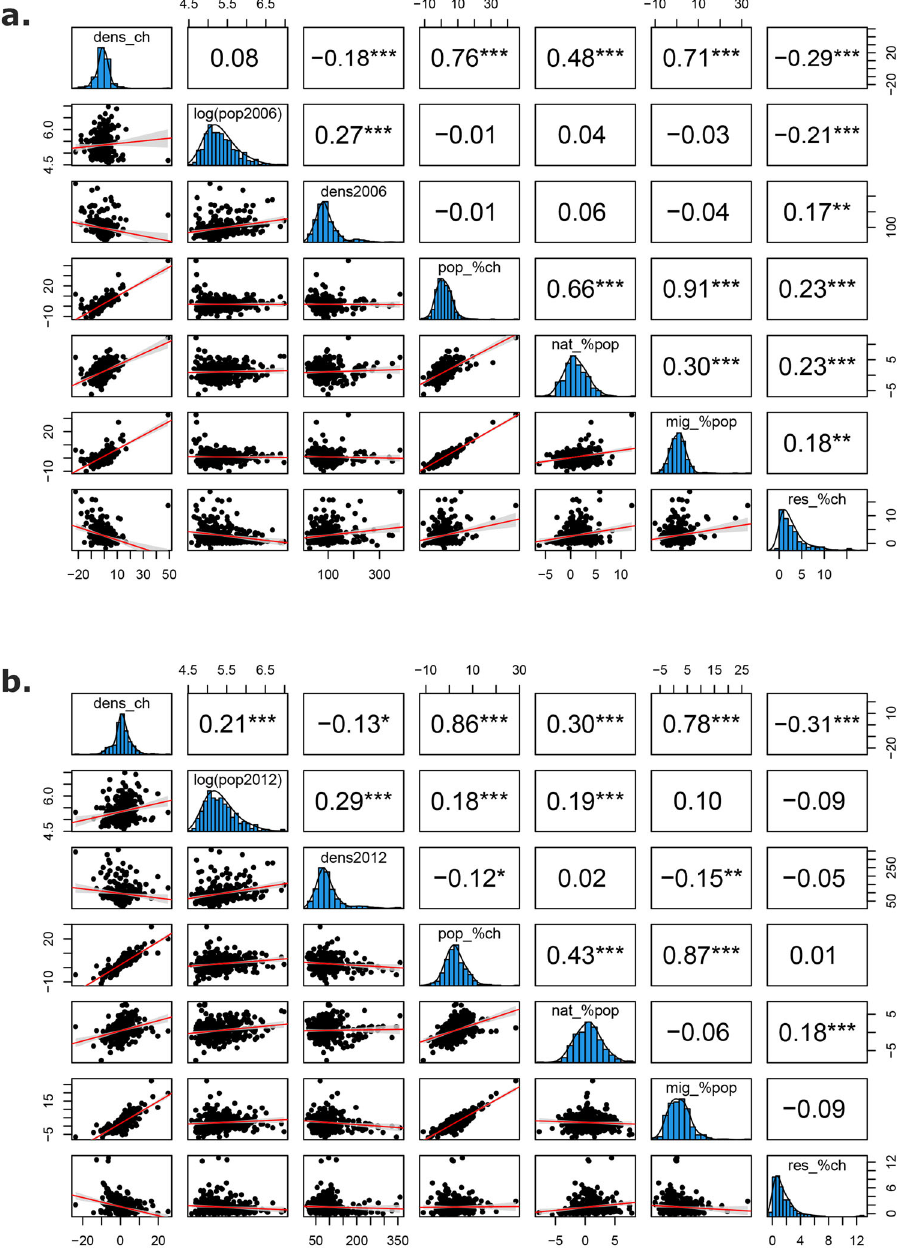
Fig. 6 Pairwise correlation between density trends and changes in population and residential area. Variables: dens_ch = change in residential density (persons/ha) during the period, log(pop20xx) = common logarithm of the initial population, dens20xx = initial density, pop_%ch = percental change in population during the period, nat_%pop = rate of natural growth calculated over the entire period as percentage of the initial population, mig_%pop = rate of net migration calculated over the entire period as percentage of the initial population, res_%ch = percental change in residential area during the period. Values in the panels above the diagonal are the Person correlation and respective signi fi cance levels: *0.05, **0.01, ***0.001. Panel ( a ) refers to the period 2006 – 2012, panel ( b ) refers to the period 2012 –